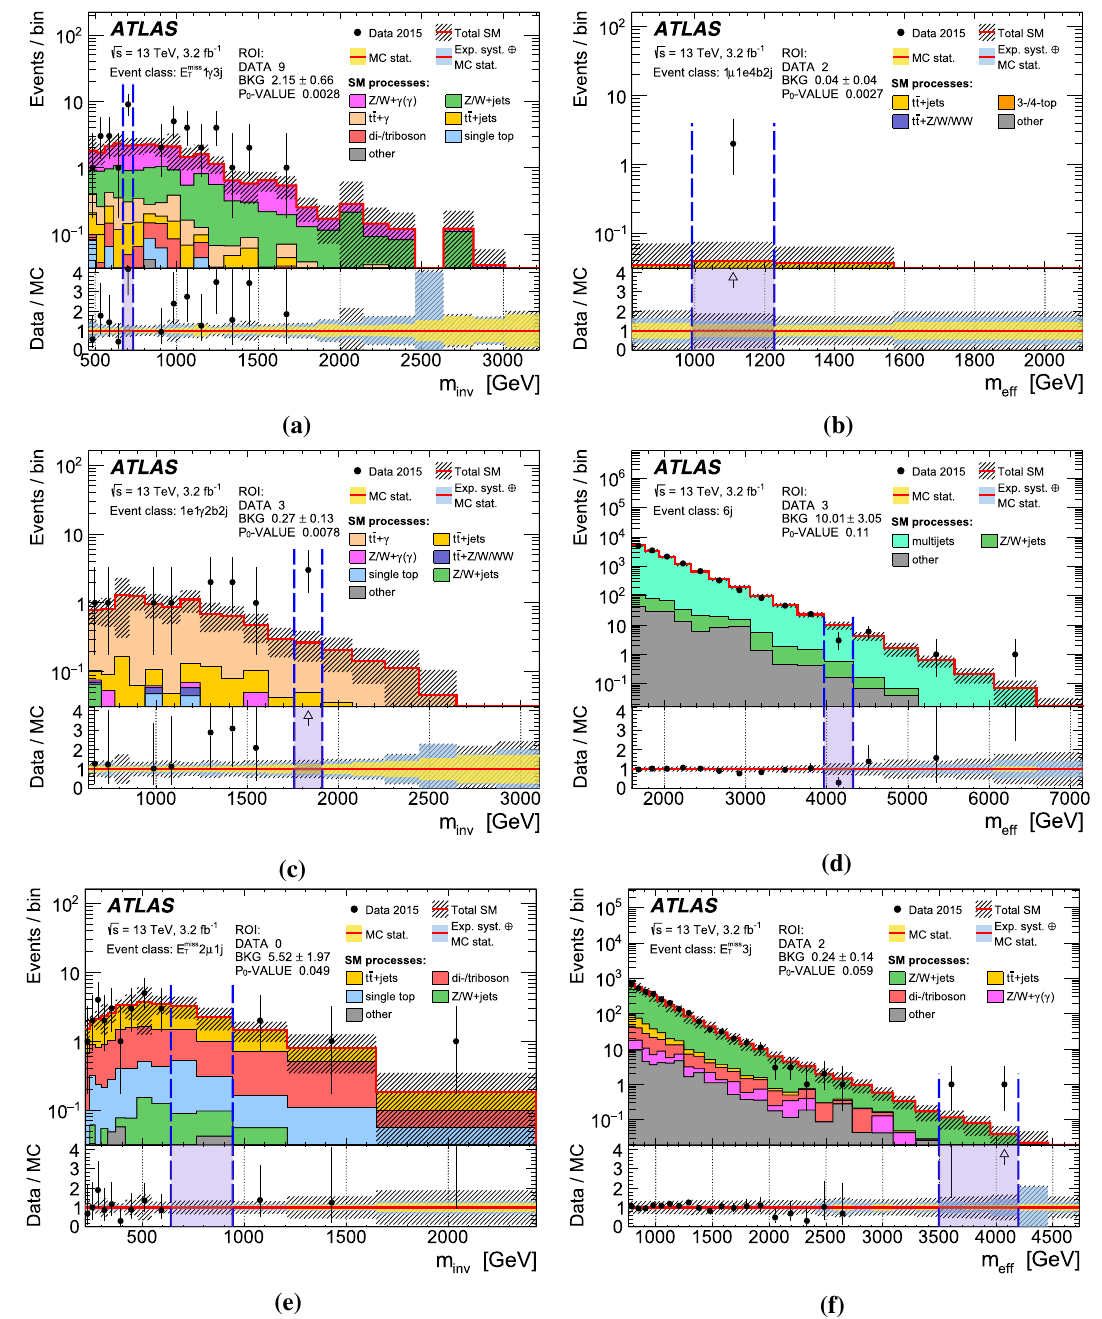
Fig. 4 Example distributions showing the region of interest (ROI), i.e. f An upward fluctuation in the m eff distribution of the E miss the region with the smallest p 0 -value, between the vertical dashed lines. The hatched band includes all systematic and statistical uncertainties a E miss from MC simulations. In the ratio plots the inner solid uncertainty band 1 γ 3 j channel, which has the largest deviation in the m inv scan. T b 1 μ 1 e 4 b 2 j channel, which has the largest deviation in the m eff scan. c shows the statistical uncertainty from MC simulations, the middle solid band includes the experimental systematic uncertainty, and the hatched Anupwardfluctuationinthe m inv distributionofthe1 e 1 γ 2 b 2 j channel. d A downward fluctuation in the m eff distribution of the 6 j channel. e A band includes the theoretical systematic downwardfluctuationinthe m inv distributionofthe E miss 2 μ 1 j channel. T